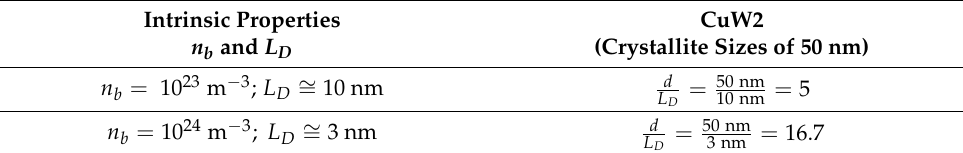
Table 4. The connection between the intrinsic properties and the size of the crystallites. Intrinsic Properties